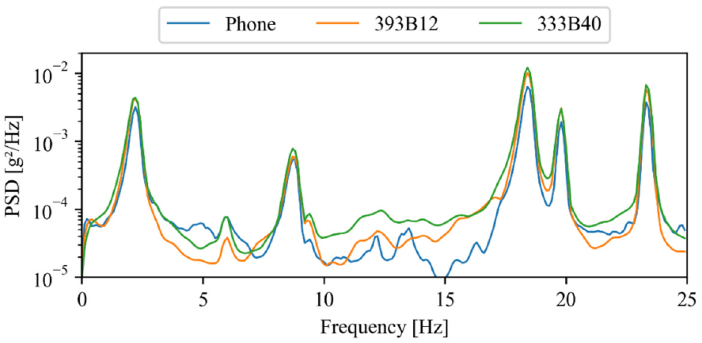
Figure 11. Average power spectral densities.